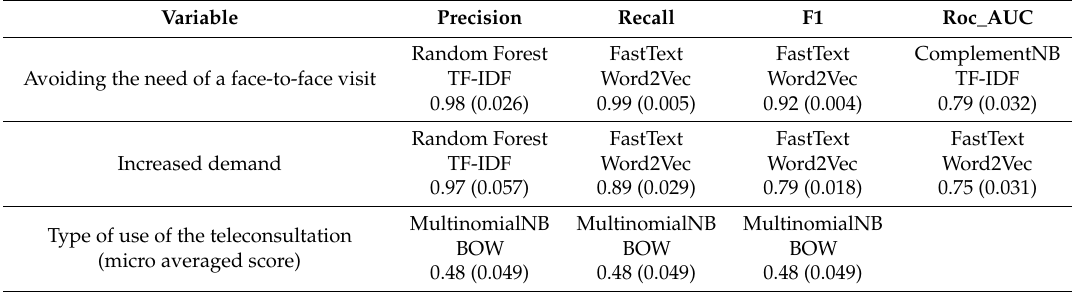
Table 4. Results of the best algorithm/text representation combination, according to the variable to be approximated. Average (SD) of the 10 iterations.